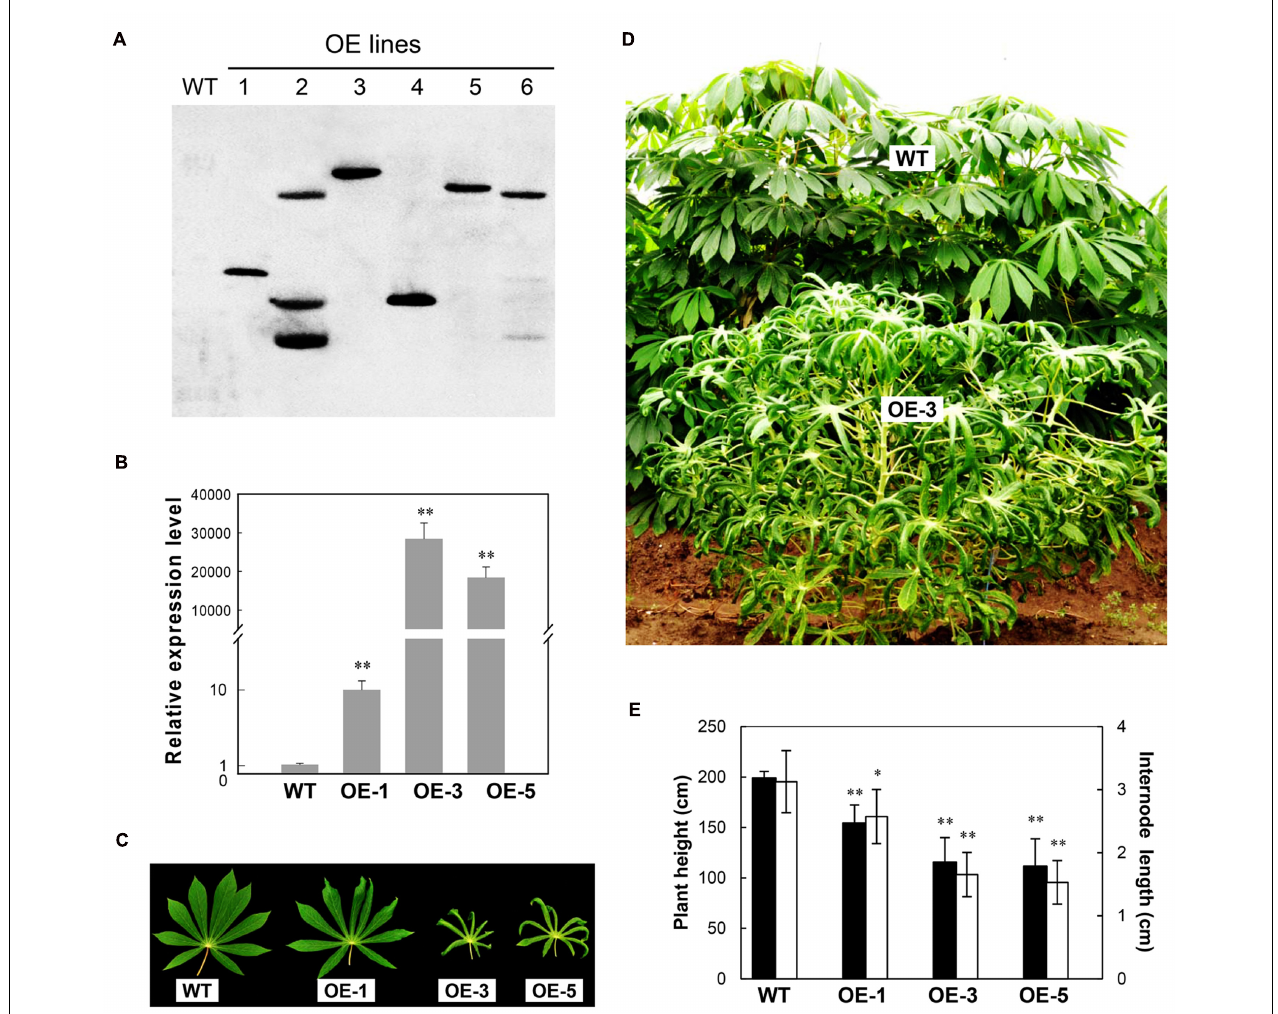
FIGURE 1 | Molecular and phenotypic characterization of Arabidopsis CBF3 overexpressing cassava. (A) Transgene integration pattern in wild-type (WT) and transgenic (OE) lines by Southern analysis. (B) Quantitative analysis of the DREB1A/CBF3 expression in WT and three single-copied transgenic lines (OE-1, OE-3, and OE-5) by real-time RT-PCR. (C) Leaves collected from field-grown plants. (D) Plant status in the field by comparison of WT and OE-3 plants. (E) Plant height and internode length between WT and OE plants. Data are presented as mean ± SD of three independent assays; asterisks indicate significant differences compared with the WT, ∗ P < 0.05 or ∗∗ P < 0.01 by Student’s t